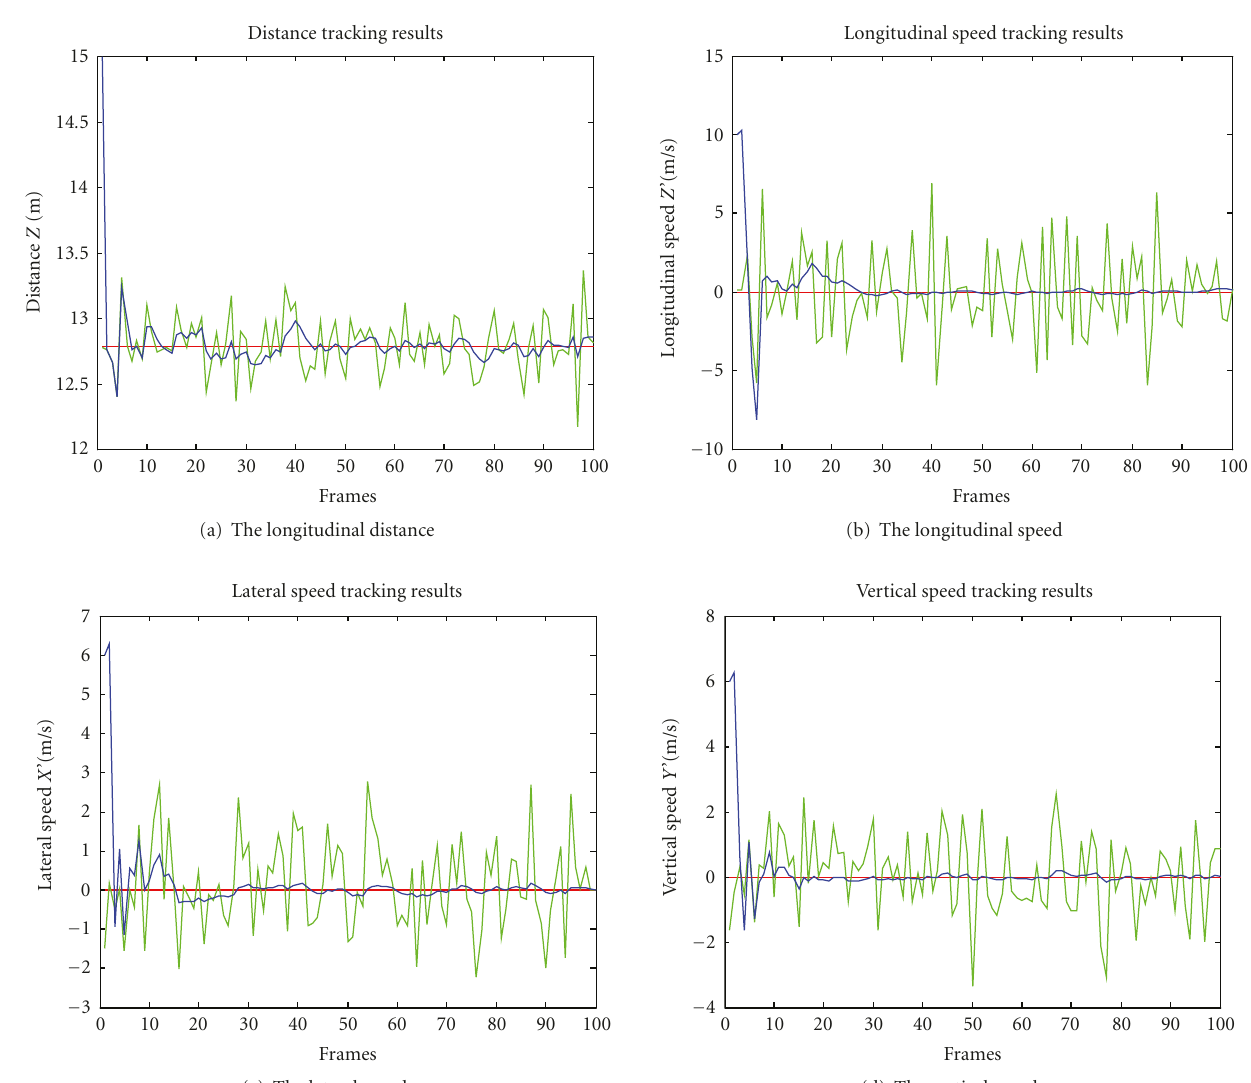
Figure 5: Experiment 1: tracking results by using a Kalman filter as a mixer (red: the true state of the system, green: the measurement results, blue: the estimation of the Kalman